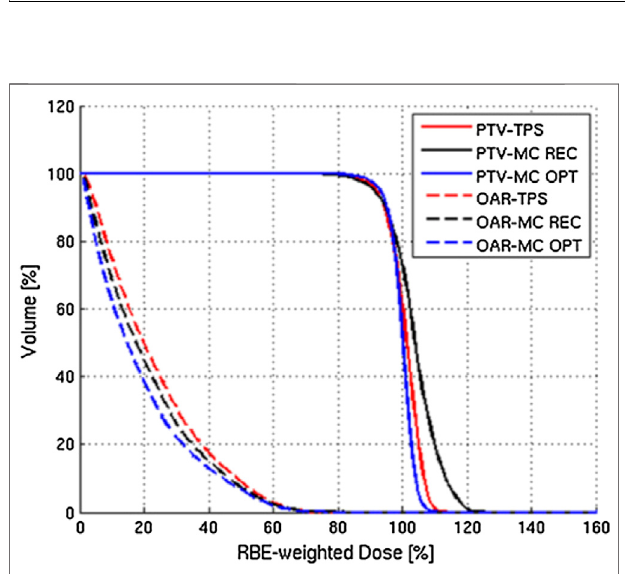
FIGURE 8 | Work fl ow of the multi-step procedure for dose calculation and optimization of the work of Mairani et al. [220].